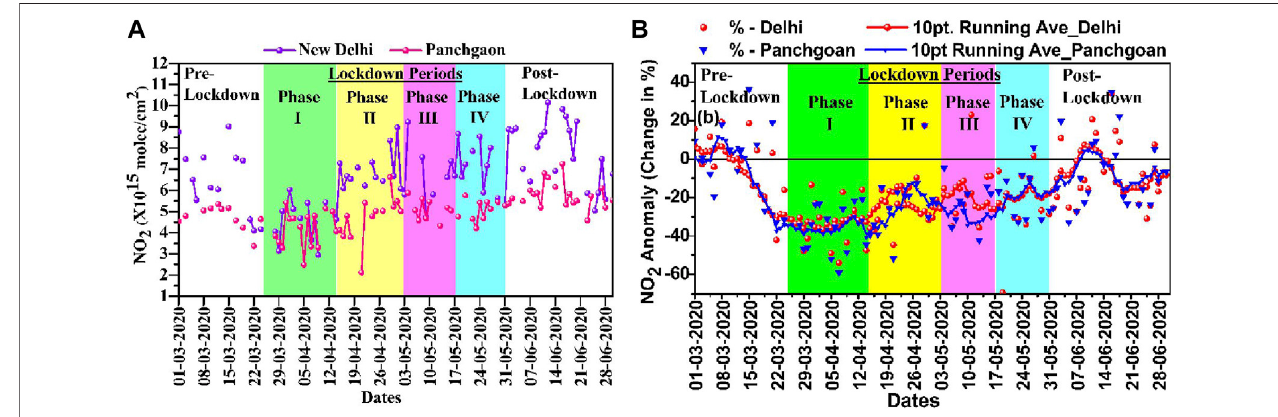
FIGURE 1 | (A) Daily variation in total column nitrogen dioxide (NO 2 ) (*10 15 molecule/cm 2 ) obtained from OMI satellite retrievals at New Delhi and Panchgaon, (B) same as (A) but for anomalies (2020 minus climatology). Climatology is obtained for the period 2010 –